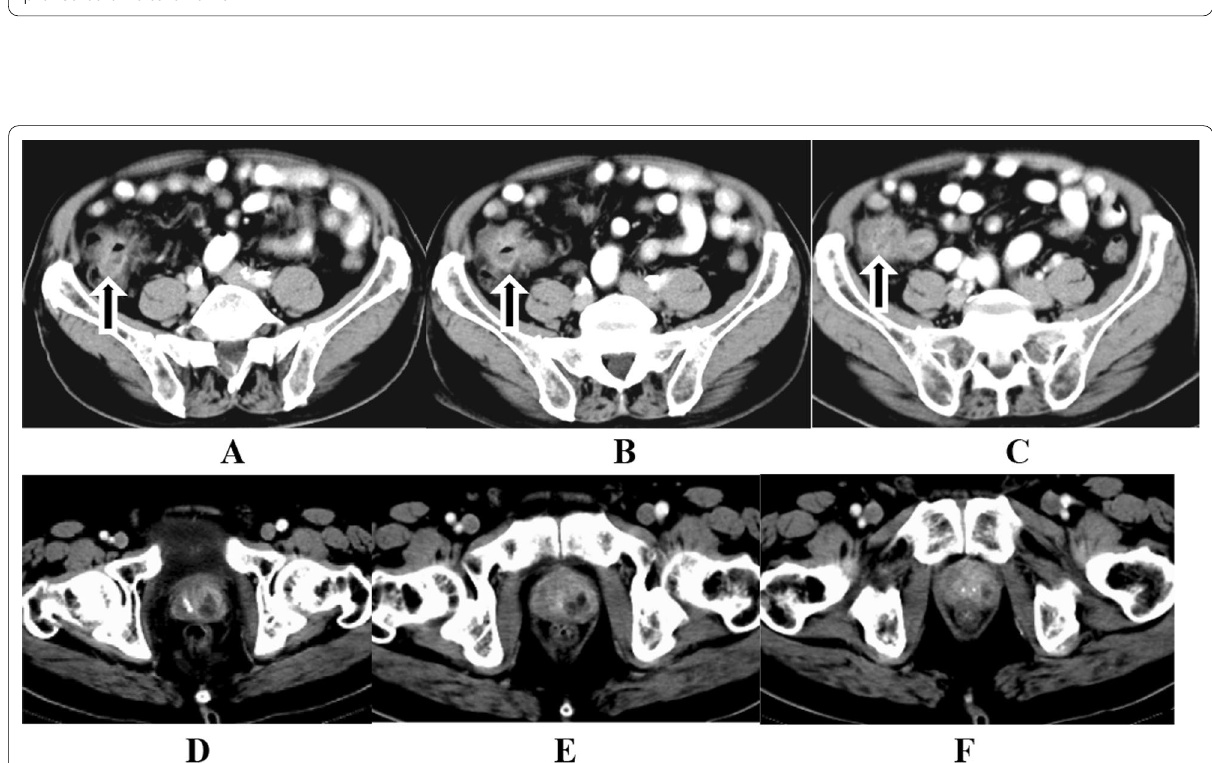
Fig. 2 76‑year‑old male presented with follow‑up during treatment for prostatic carcinoma. MDCT scan of pelvis revealed cecal mass (arrows) ( A – C ) with prostate carcinoma proved by transrectal biopsy (arrows) ( D – F